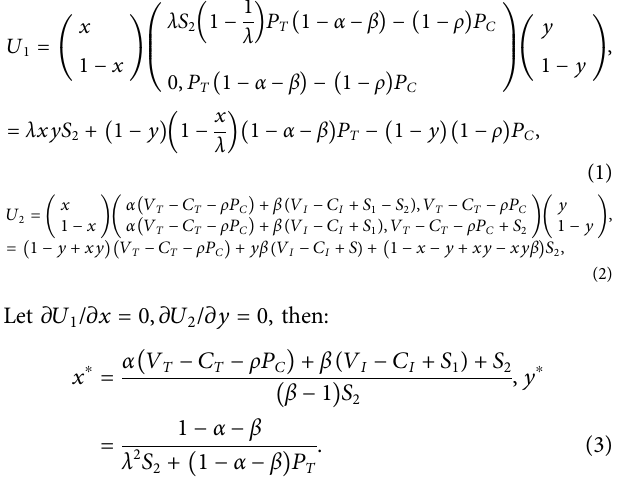
TABLE 1 | “ Leader ” power enterprises and general power enterprises ’ strategic choices. Ordinary electricity enterprise Smart